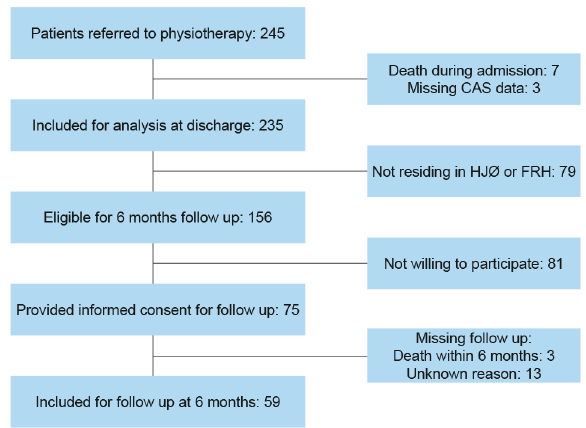
Figure 1. Flowchart of included and excluded patients. HØJ = Hjøring municipality, FRH = Frederikshavn municipality, CAS = Cumulated Ambulation Score.